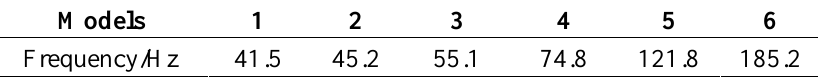
Table 1. The FEA results of the prior six modes at natural frequency.